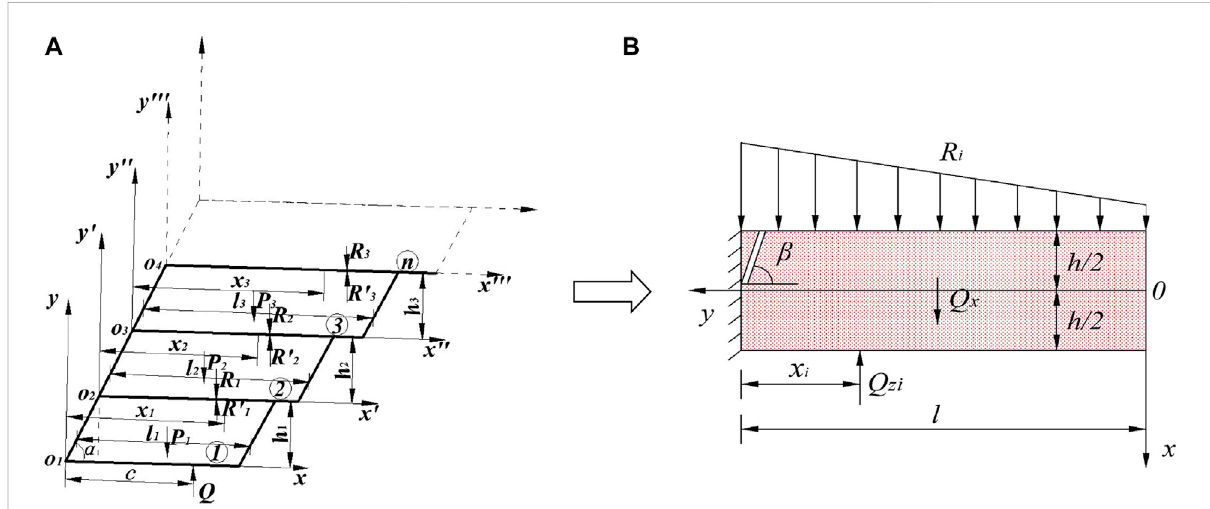
FIGURE 5 The construction of mechanical model: (A) force analysis of the model, (B) simpli fi ed mechanical analysis model of the i th cantilever beam.